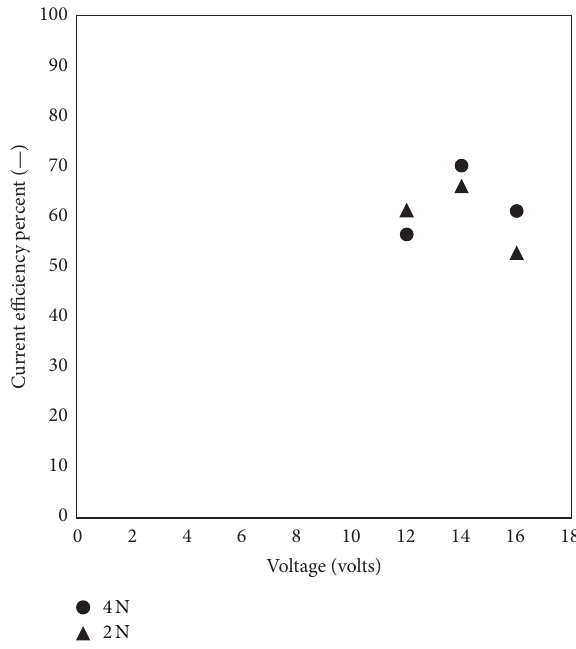
Figure 12: Conversion percent (—) and total charge (ampere hour) versus ED (mm) for 4 N feed concentration.